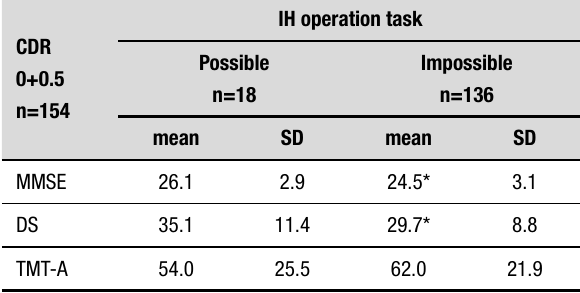
Table 3. Relationship between the induction heating operation and neuropsychological